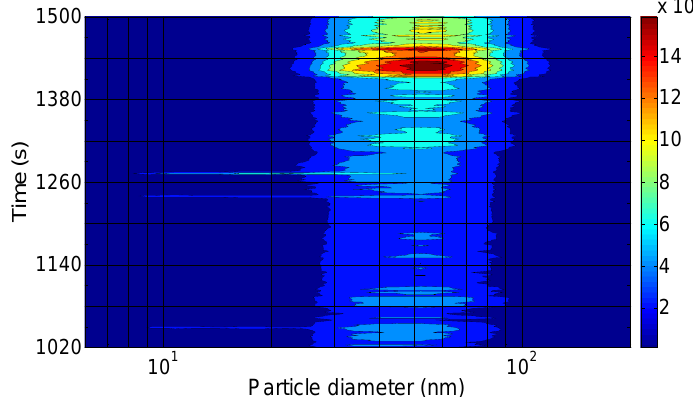
Figure 3. Temporal trend of aerosol size distribution (# cm −3 ) during the Cu-Al